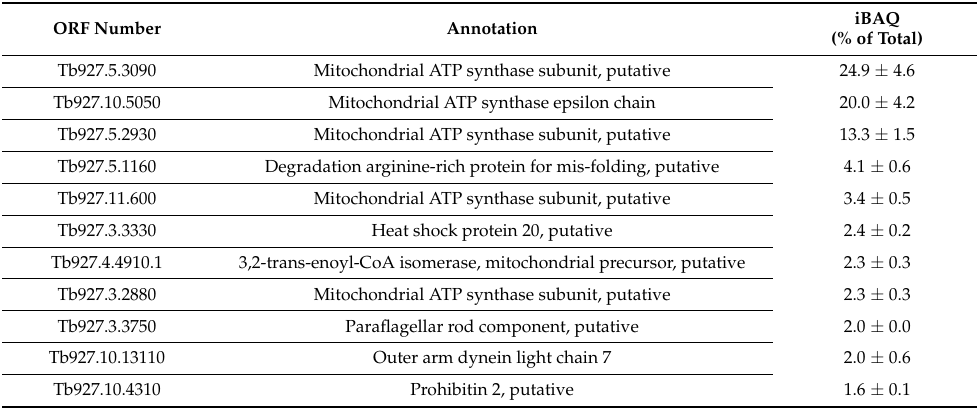
Table 3. List of the 20 most abundant proteins from T. brucei TREU927 specifically binding to a com- plex 1 column, as identified by differential affinity chromatography followed by mass spectrometry. See Table S2 for the full dataset. The abundance is given as the percentage of the iBAQ values, with 100% being the sum of the iBAQ values of the 48 proteins specifically binding to 1 . Mean values ± standard errors of three replicates are